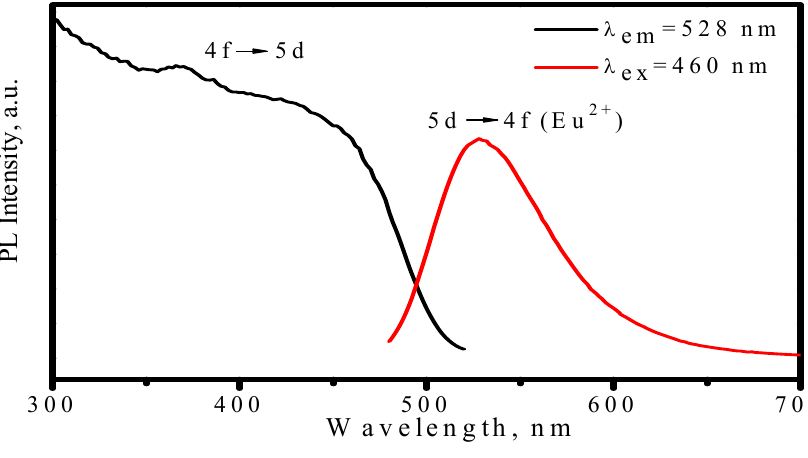
= 460 nm) spectra of ex